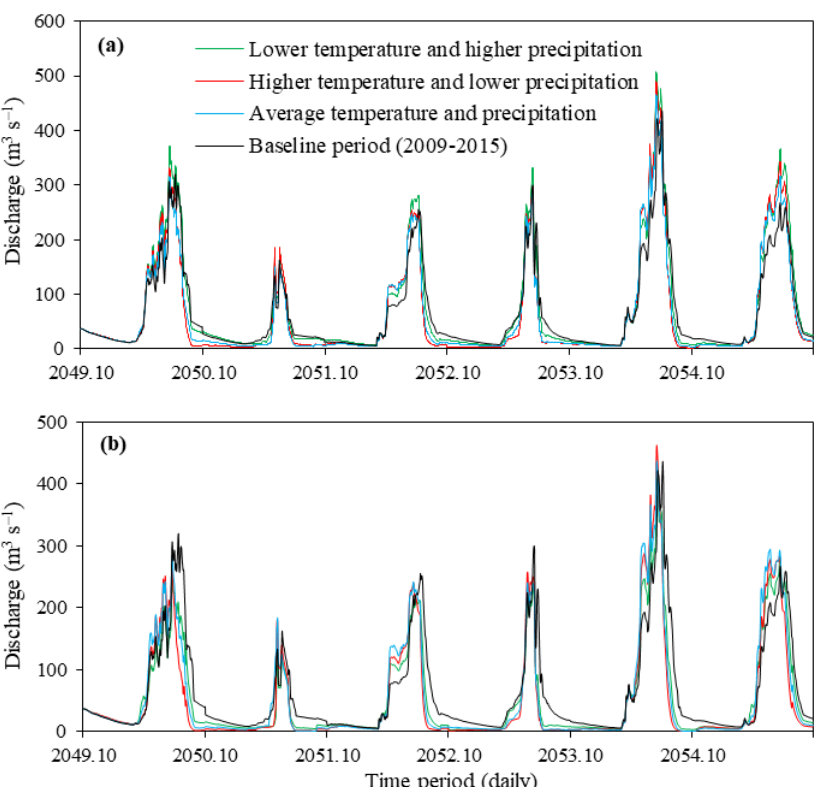
Figure 9. Projected river flows during the mid-21st century (2049–2055) under ( a ) RCP 4.5 and ( b ) RCP 8.5, for the average, lower, and higher temperature and precipitation scenarios and the resulting projected SCAs.